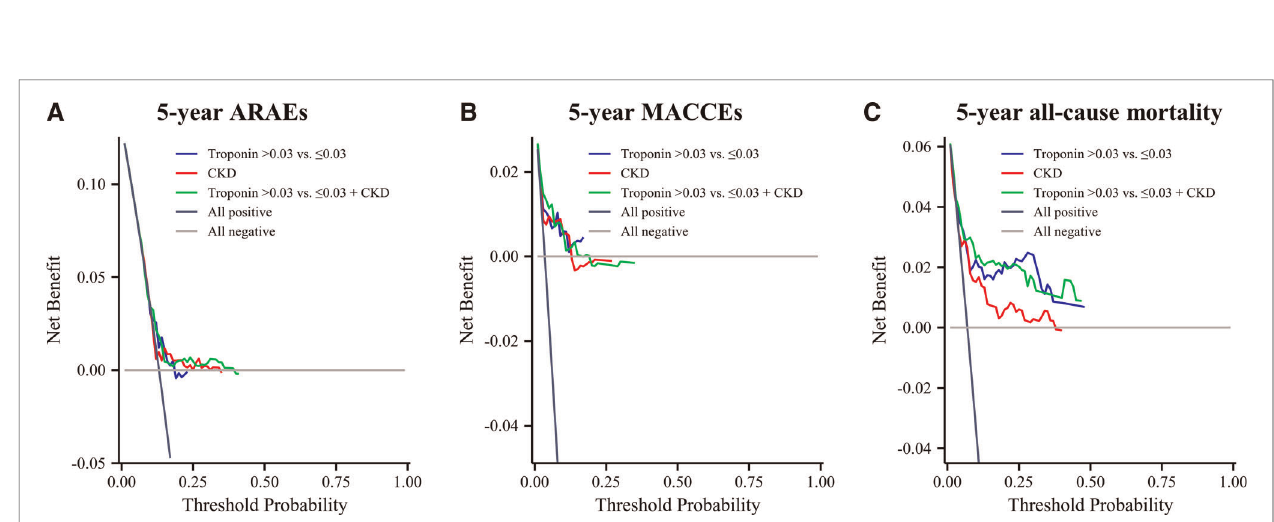
FIGURE 4 | Decision Curve Analysis. ( A ) The decision curve analysis for 5-year ARAEs; ( B ) decision curve analysis for 5-year MACCEs; ( C ) decision curve analysis for 5-year all-cause